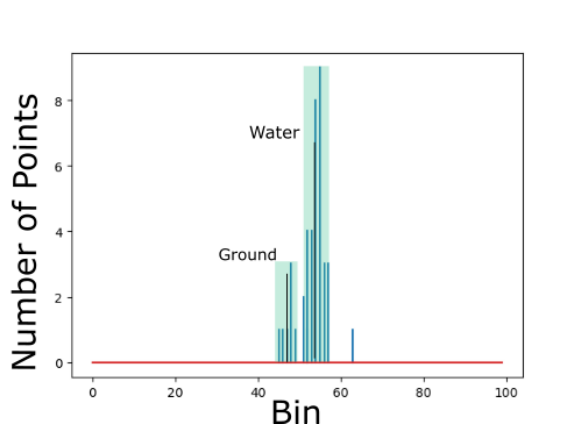
Figure 1. Schematic histogram based classification into ground and water points